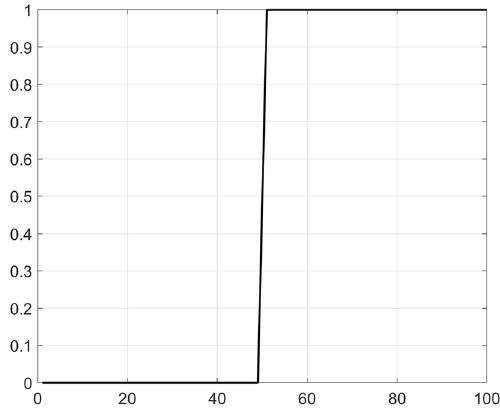
Figure 4. Logistic function.